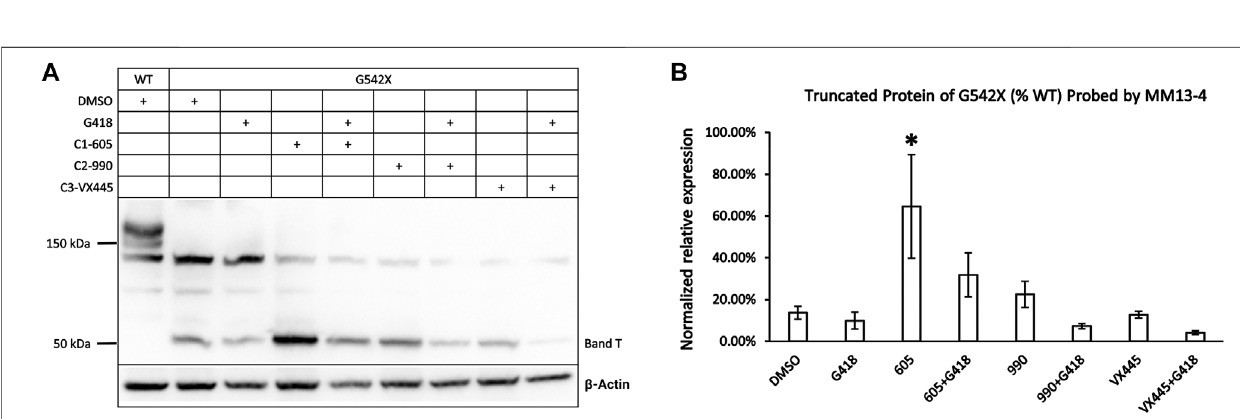
FIGURE 2 | Immunoprecipitation (IP) and mass spectrometry (MS) experiments for the band C of WT-CFTR and the band T of G542X-CFTR. (A) Western blots of WT-CFTR and G542X-CFTR after immunoprecipitation with mouse monoclonal anti-CFTR N-terminalantibody MM13-4. Two bands forWT (band Cand band B witha molecular weight of ~170 and ~150 kDa, respectively), and one band for G542 (band T with a molecular weight of ~52 kDa) were identi fi ed. (B) Schematic representation of MS results. The dark blue regions represent the identi fi ed peptides. The horizontal axis marks the numbers of the amino acid residues in CFTR.